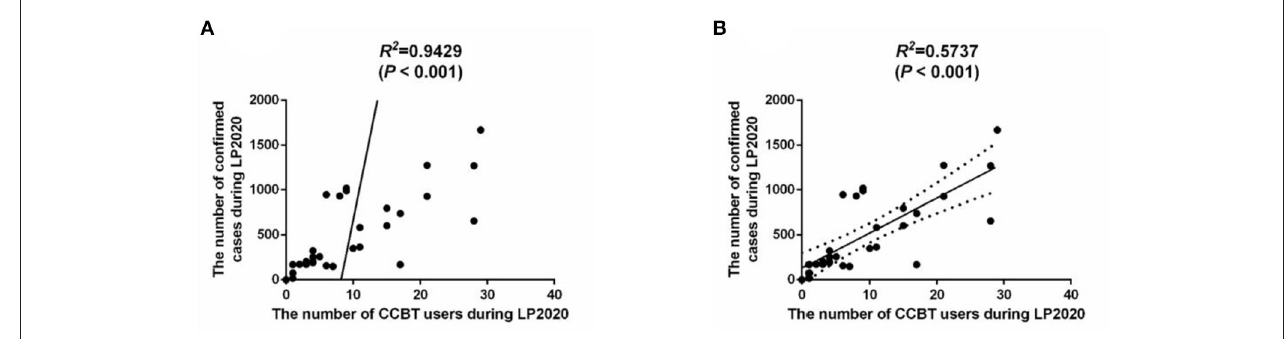
FIGURE 3 | (A) The change of SAS score in SP2019, (B) the change of SAS score in LP2020, (C) the change of SDS score in SP2019, and (D) the change of SAS score in LP2020.